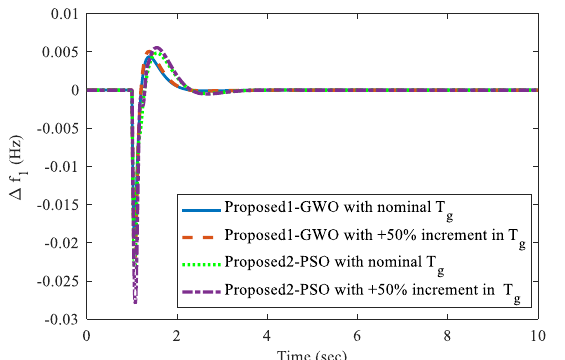
Fig. 18 Frequency regulation in area 1 with + 50% perturbation in Tg for case 5d